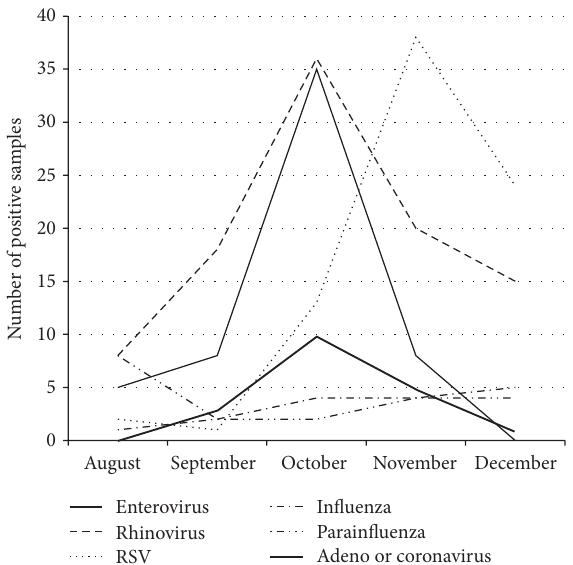
Figure 2: Respiratory viruses isolated from nasopharyngeal sam- ples, 2014.